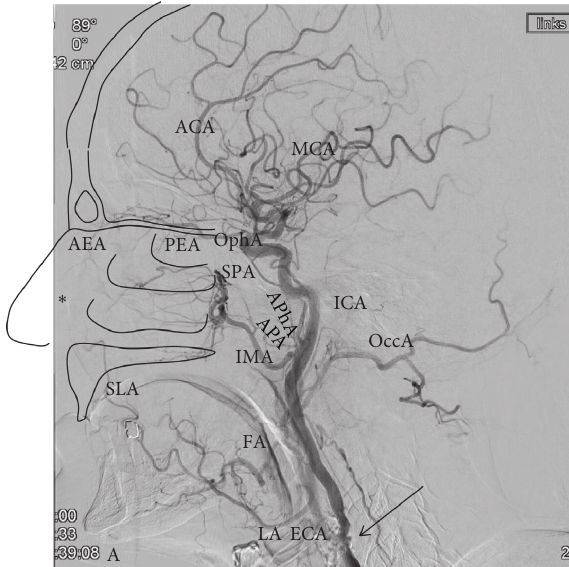
Figure 1: Arterial supply of nasal cavity. Digital subtraction an- giography via the common carotid artery shows branches of the external and internal carotid artery (ECA and ICA; 90 ° LAO). For better understanding of the anatomy some anatomical structures like the nasal conchae, the floor of nasal cavity, nose, and fron- tobasis are drawn schematically. The major part of blood supply for the nasal cavity is provided via branches of the ECA. Especially the sphenopalatine artery (SPA), and end-branch of the internal maxillary artery (IMA), is the main blood supply for the nasal cavity and for Kiesselbach’s plexus (asterisk). The roof of the nasal cavity is supplied by the anterior ethmoidal artery (AEA) and posterior ethmoidal artery (PEA), which are branches of the ophthalmic artery (OphA), i.e., branches of the internal carotid artery (ICA). The blood supply to the floor of the nasal cavity originates from ascending palatine arteries (APA) from the facial artery (FA) and descending palatine artery (DPA) from IMA. Little supply to Kiesselbach’s plexus comes from the superior labial artery (SLA), an end-branch of the FA. And, finally minor supply to the posterior area of the nasal cavity is provided by the ascending pharyngeal artery (APhA), which originates from the ECA. Note the calcification of proximal ICA (arrow). Also shown are occipital artery (OccA), ophthalmic artery (OPhA), and intracranial arteries like anterior and middle cerebral artery (ACA and MCA). As ICA and ECA both contribute to the blood supply of the nasal cavity sometimes, there are some “dangerous” anastomoses, which can cause blindness or stroke when accidentally embolized during the procedure. These potentially “dangerous” anastomoses include the artery of the foramen rotundum, the middle meningeal artery, the accessory meningeal artery, the ethmoidal arteries, the APhA, and of course the communications between the FA and